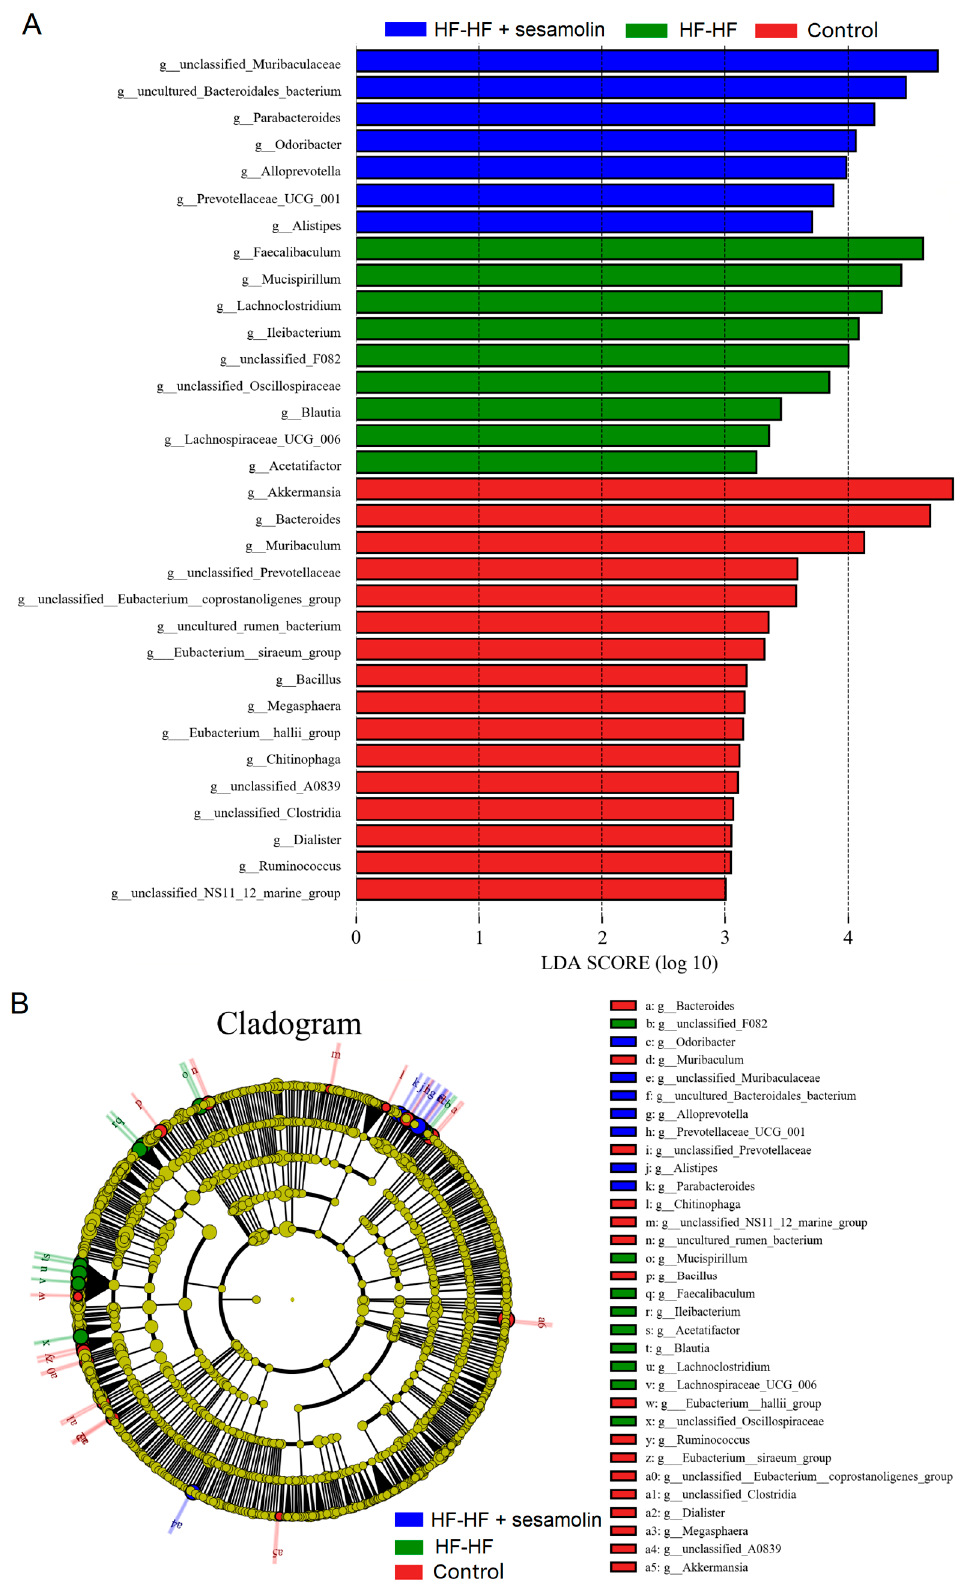
Figure 5. LEfSe analysis of gut microbial composition at the genus level. ( A ) Histogram of the LDA scores computed for differentially abundant bacterial taxa. ( B ) The Cladogram of taxonomic distribution in the different groups (LDA score, >3.5). Different letters express significant differences, p <